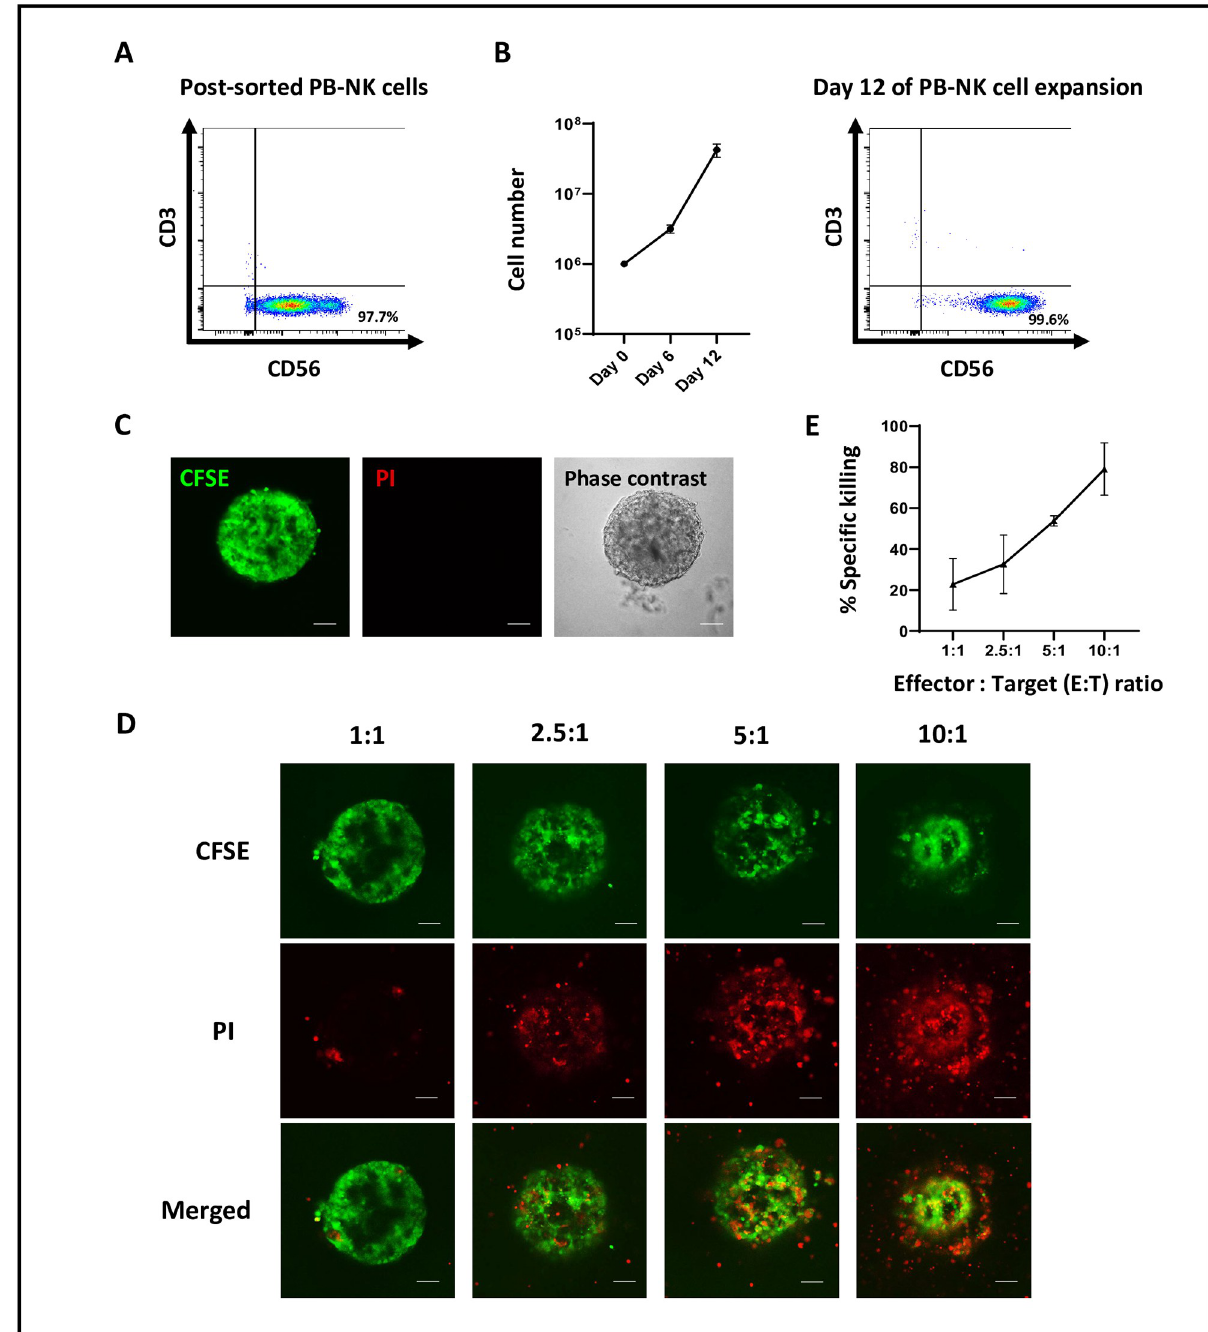
Fig 2. Evaluation of NK cell cytotoxic activity toward 3D tumor spheroids. (A) Flow cytometric analysis of the NK cell-related markers (CD45, CD3, and CD56) of the post-sorted PB-NK cells. (B) Proliferation and flow cytometric analysis of the PB-NK cells in the presence of the genetically modified mIL-21-K562 cell line and hIL-2 (PB-NK cells were isolated from 2 donors, n = 2). (C) Fluorescent and phase-contrast images of the CFSE-labeled KKU213A tumor spheroids in the culture medium containing 2.5% Matrigel 1 matrix on day 2. Green = tumor cells (CFSE), Red = dead cells (PI), scale bar = 20 μ m. (D) Representative fluorescent images of the PB-NK cells and the 3D tumor spheroids at different effector to target ratios (E: T) (1:1, 2.5:1, 5:1, and 10:1). Green = tumor cells (CFSE). Red = dead cells (PI), scale bar = 20 μ m. (E) Cytotoxic activity of the PB-NK cells against 3D tumor spheroids at 1:1, 2.5:1, 5:1, and 10:1. The PB-NK cells were obtained from 2 donors. Data are presented as mean ± SEM (n = 2).